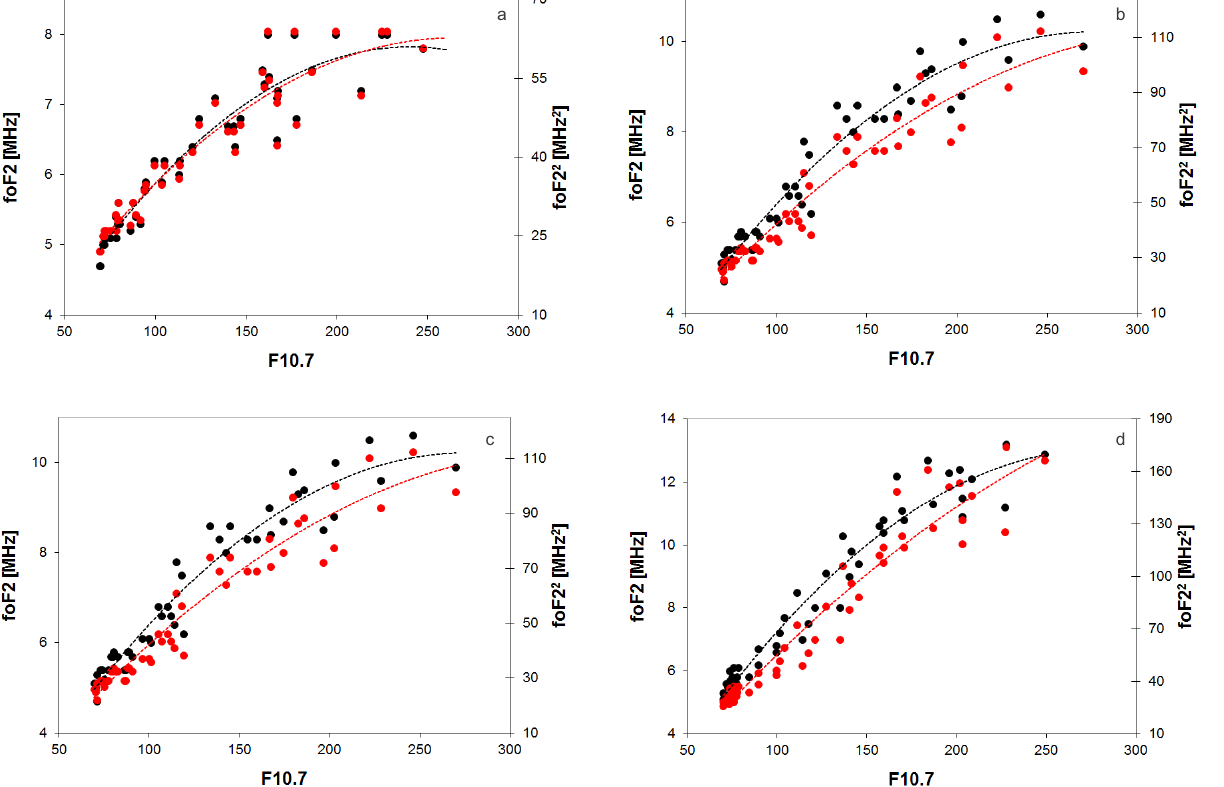
Figure 1. foF2 (black circles) measured at Slough, and foF2 2 (red circles) in terms of F10.7 for (a) June, (b) September, (c) December, and (d) March. Dotted lines correspond to a polynomial fit of order 2. The foF2 data are monthly median values for period